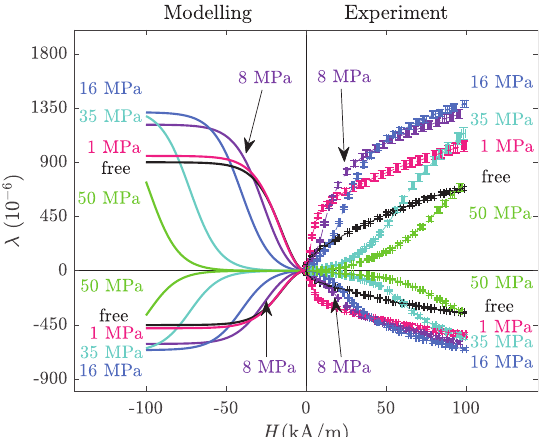
Figure 6. Longitudinal ( top ) and transverse ( bottom ) anhysteretic magnetostriction strain under uniaxial compressive stress: analytical model ( left ) and experimental results with the corresponding error bars ( right